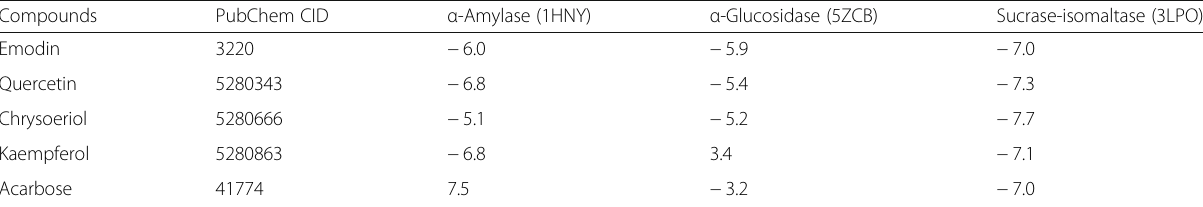
Table 2 Comparison of predicted binding free energies (kcal/mol) amongst the compounds Compounds PubChem